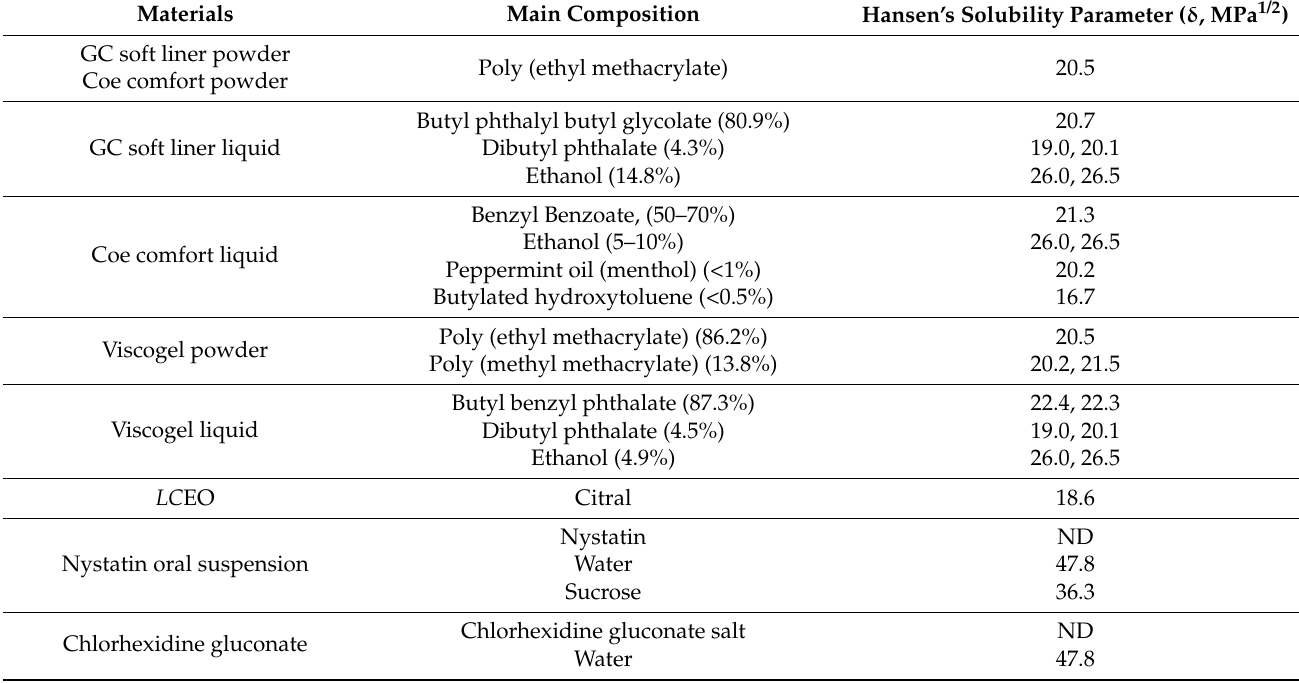
Table 9. Summary of solubility parameters ( δ , MPa 1/2 ) of main composition in GC soft liner,